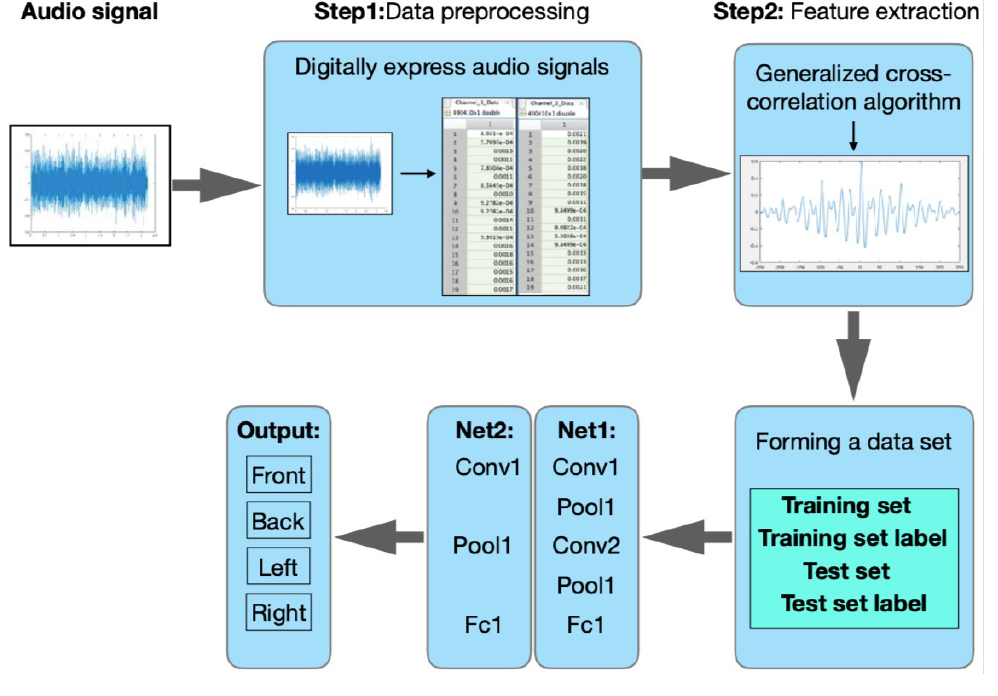
Figure 2: Sound direction recognition model flow